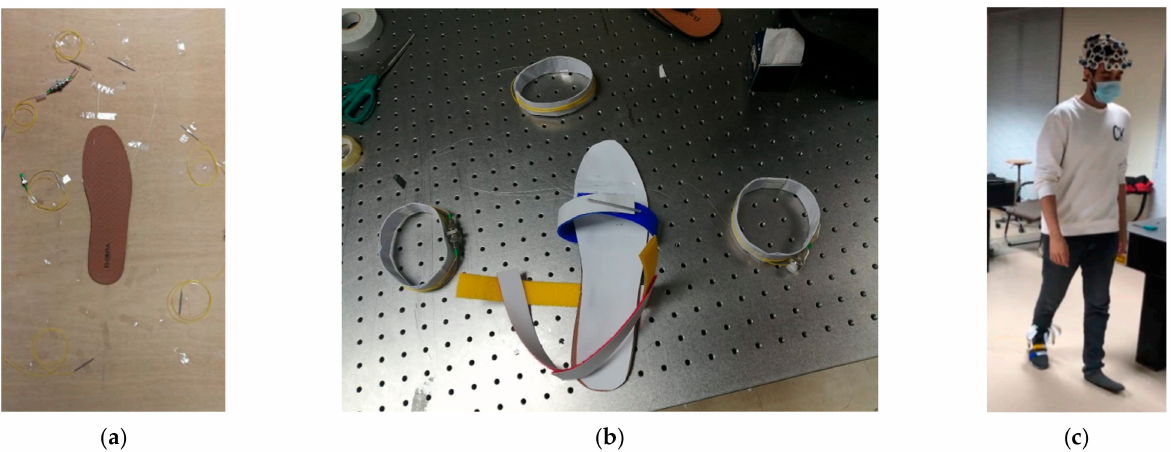
Figure 9. ( a ) Three FBGs installed on the insole; ( b ) sandal prepared for multi-user use; ( c ) a partici- pant walking while wearing the BCI headset and the FBG installed